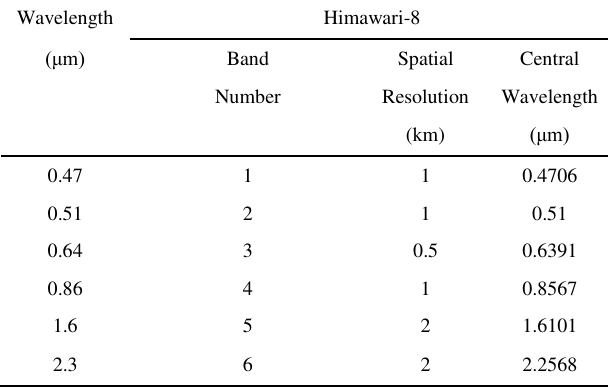
Table 1. Visible and infrared bands of the Advanced Himawari Imager.